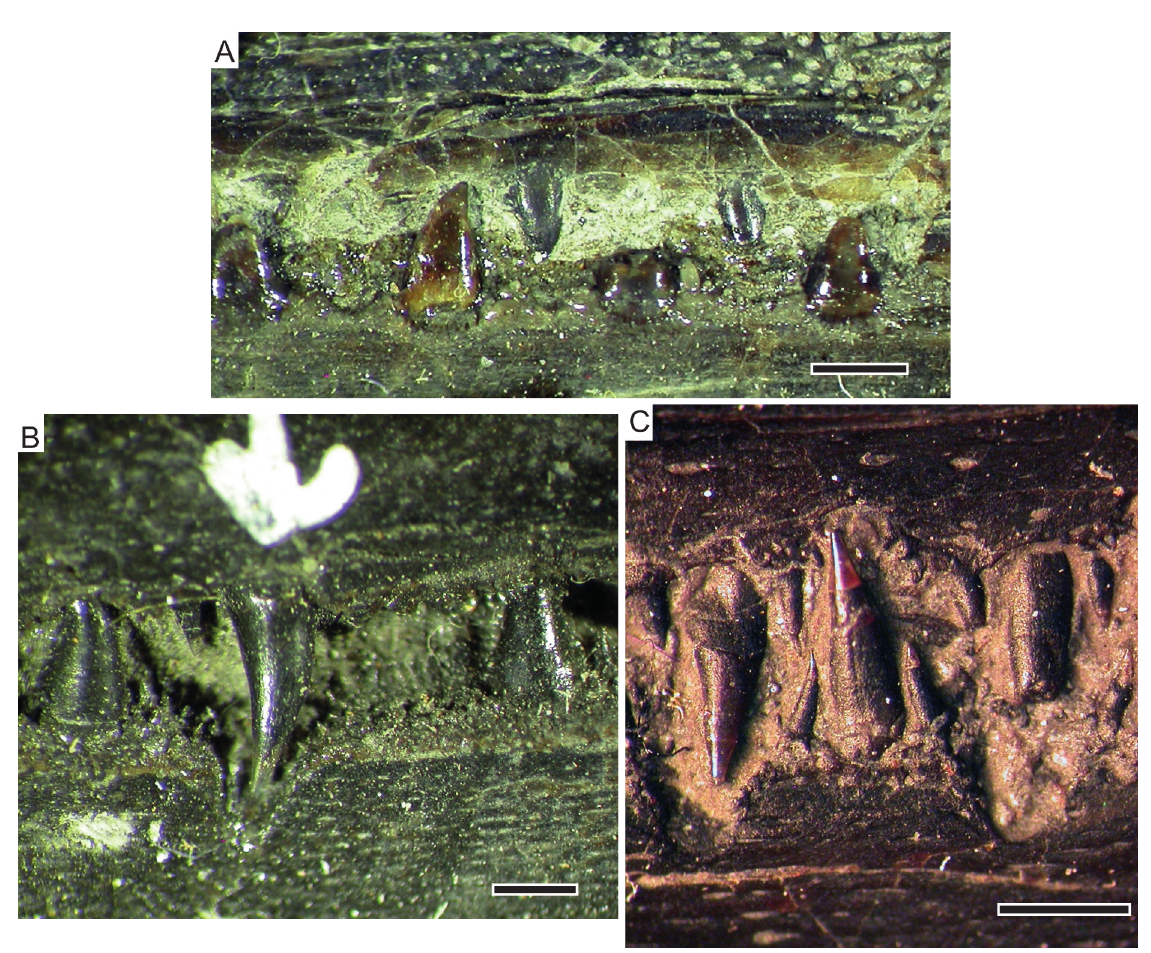
Fig. 6. Posteriormost laniary dentition. A . Saurorhynchus brevirostris (Woodward, 1895) (NHMUK PV P 4878), note the lingually curved crowns. B . Saurorhynchus anningae sp. nov. (NHMUK PV P